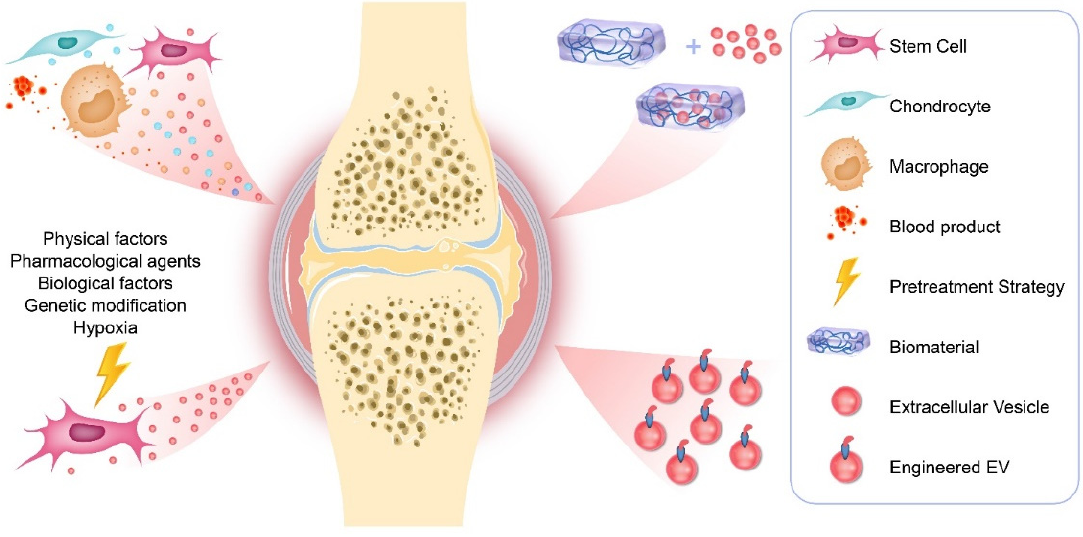
Figure 1. Therapeutic applications of EVs in OA.